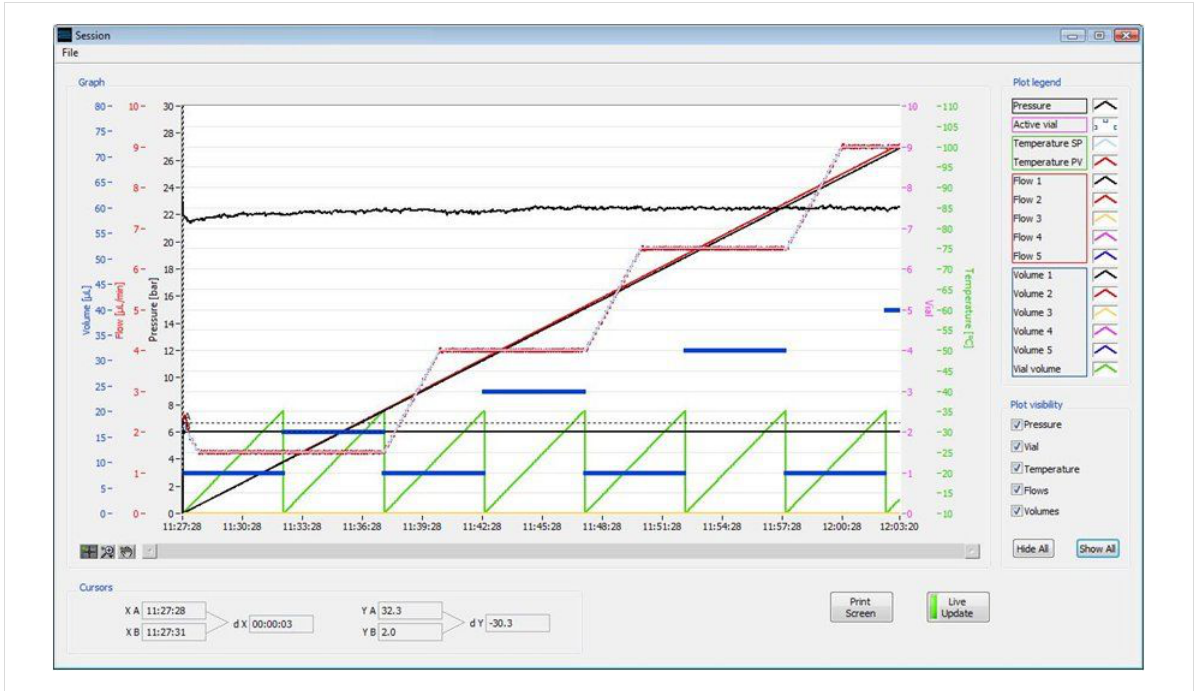
Figure 11: Graphical representation of an automated flow reaction for equilibration and screening of reactor temperature